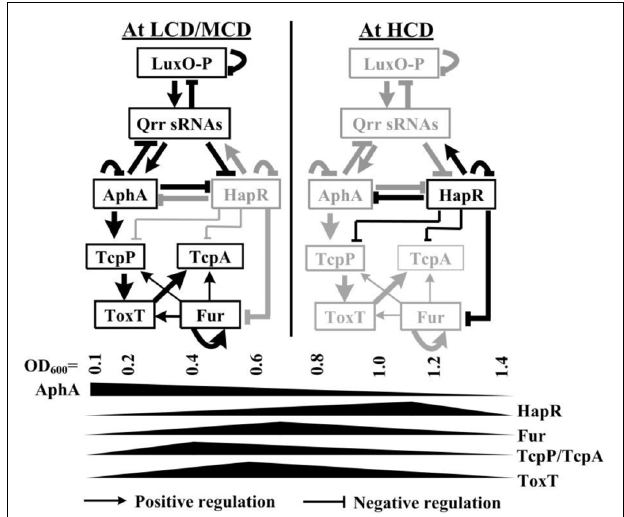
FIGURE 1 | Regulatory model. The regulatory relationships between LuxO, Qrrs, AphA, and HapR (or its homologous protein) have been previously reported in vibrios (Henke and Bassler, 2004; Tu et al., 2010; Rutherford et al., 2011; Sun et al., 2012b; Zhang et al., 2012). AphA and HapR are the bottom master regulators of QS operating at LCD and HCD, respectively. Fur coordinates with HapR to tightly regulate tcpP , toxT , and tcpA , leading to the cell density transcriptional manner of expression of these genes. HapR repression of Fur (Gao et al., 2018), AphA activation of tcpP (Kovacikova and Skorupski, 2001; Kovacikova et al., 2004), TcpP activation of toxT (Krukonis et al., 2000), autoregulation of Fur (Lee et al., 2007), and ToxT activation of tcpA (DiRita et al., 1991) were reported by other researchers. LCD, low cell density; MCD, medium cell density; HCD, high cell